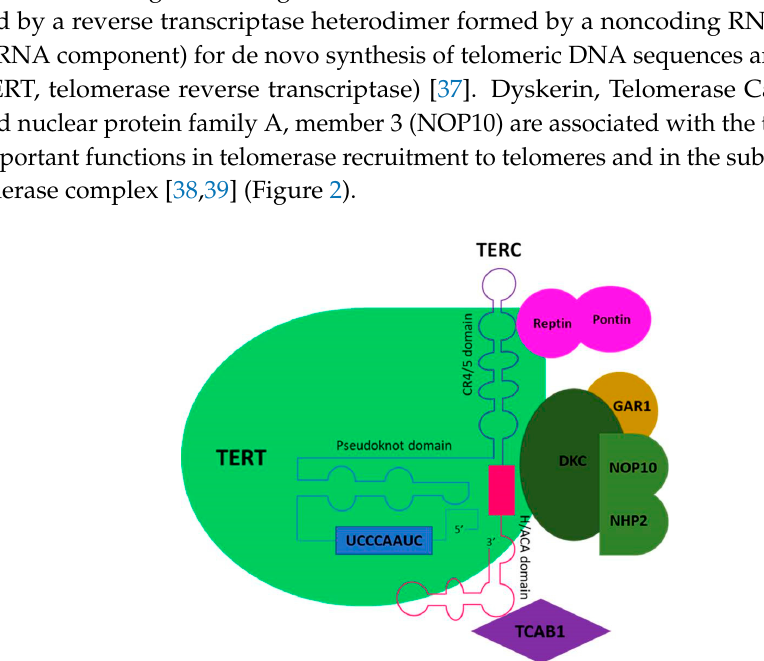
Figure 2. Telomere elongation relies on telomerase, a ribonucleoprotein including a catalytic subunit telomerase reverse transcriptase (TERT) and an RNA component (TERC). Telomerase extends telomeres by adding hexameric 5 ′ -TTAGGG-3 ′ tandem repeats to the chromosomal ends via reverse transcription using an intrinsic RNA template region (UCCCAAUC). TERT protein comprises